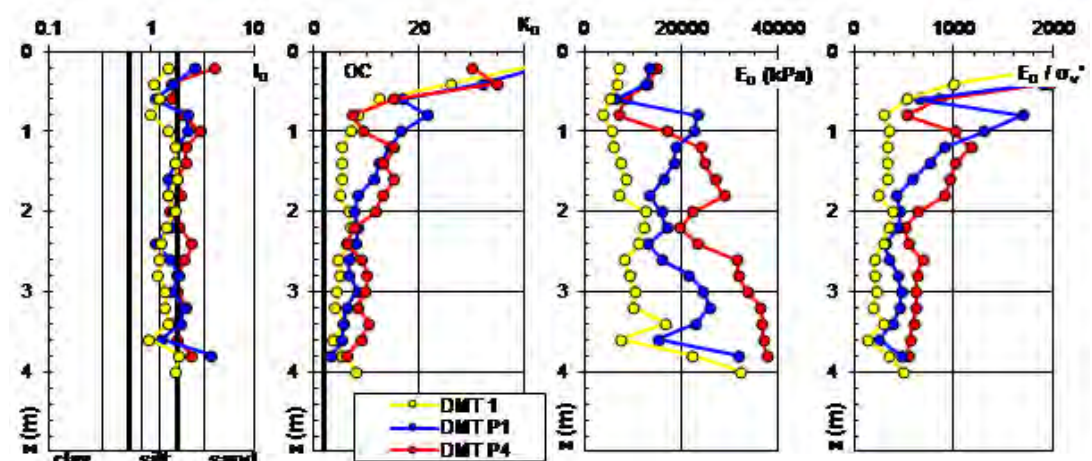
Figure 16. Intermediate DMT results. DMT 1 before RIC, DMT P1 and DMT P4 after RIC performed on sub-fields P1 and P4.